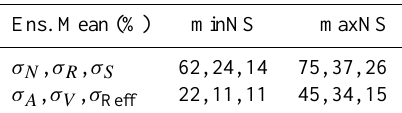
Table 4. Ensemble mean retrieved uncertainties (in %) in num- ber density, median radius, distribution width, surface area density, volume density, and effective radius for both the minimum noise scenario (minNS) and the maximum noise scenario